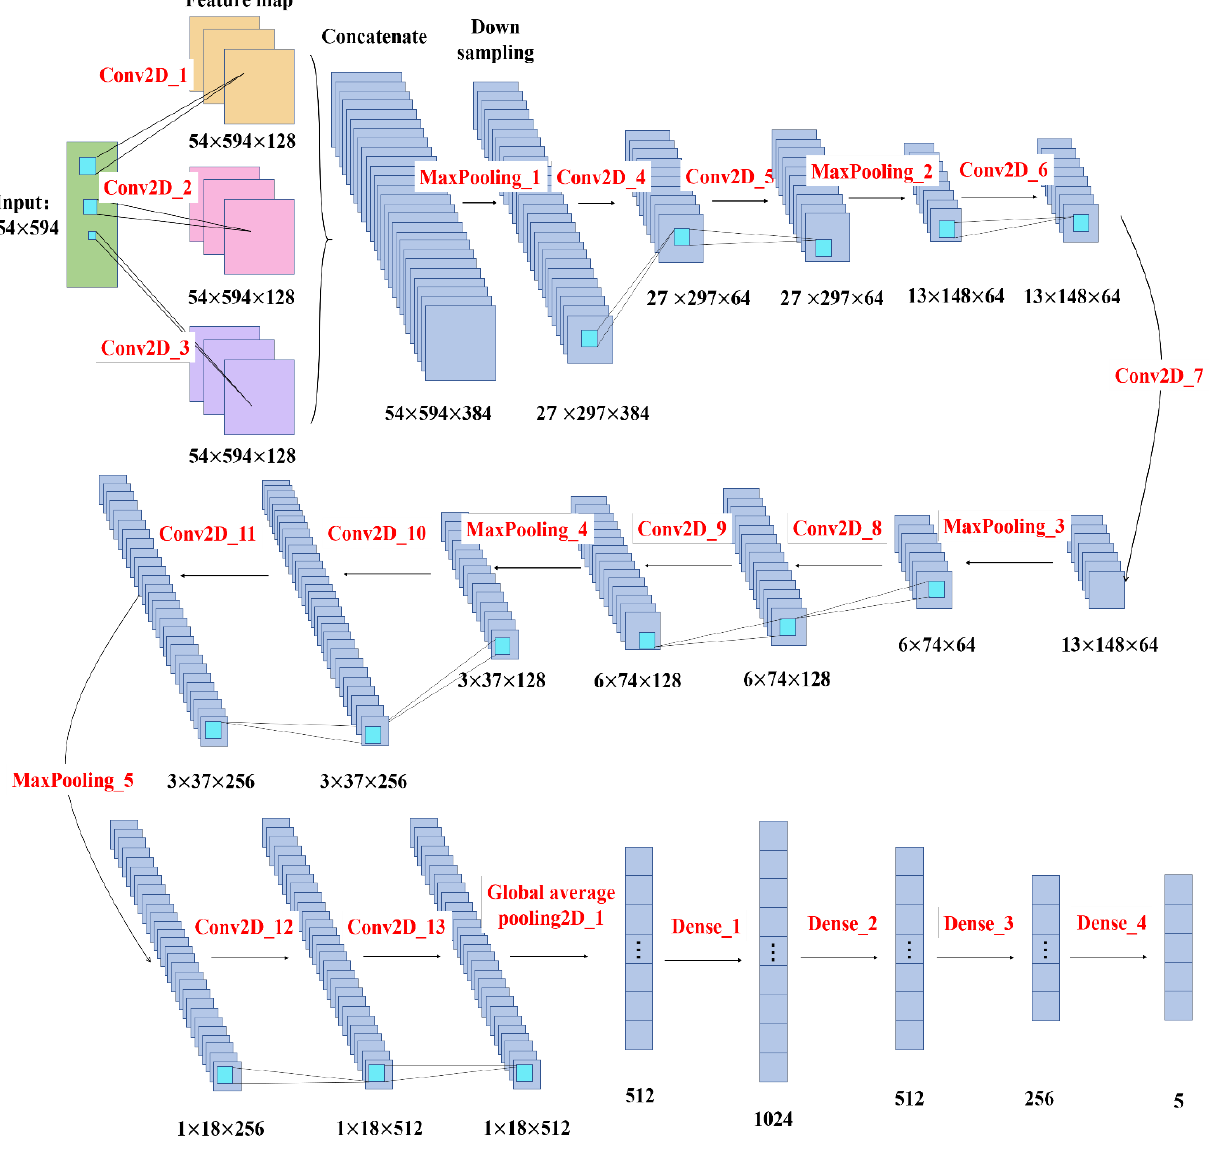
Figure 9. Convolution neural network structure.